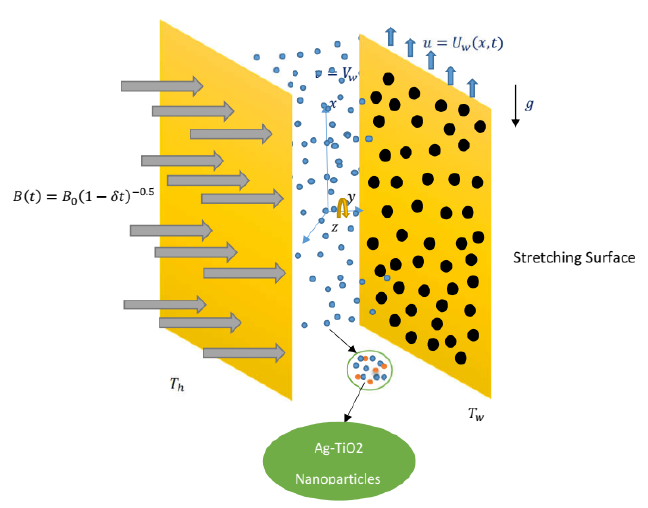
Figure 1. Problem